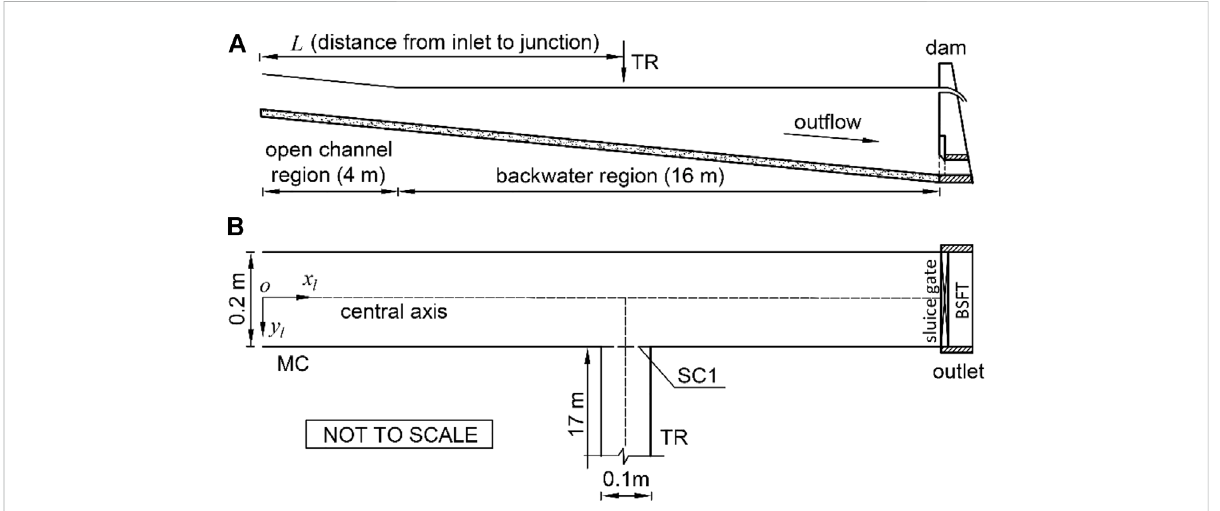
FIGURE 1 Vertical pro fi le (A) and plan view (B) of the main channel (MC) and tributary (TR). Abbreviation BSFT refers to bottom sediment fl ushing tunnel, and abbreviation SC1 refers to the cross-section located at the junction.